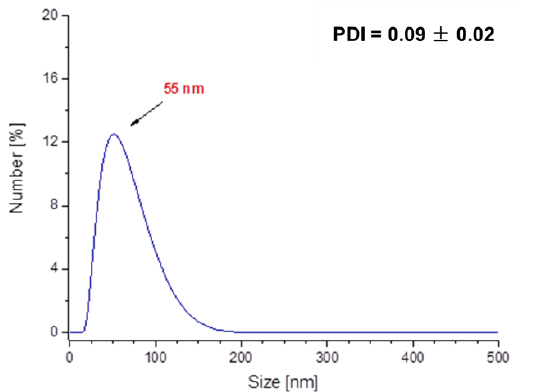
Figure 13. DLS measurement of the Fe 3 O 4 @Ag@PEG particles after 15 min of sonication.